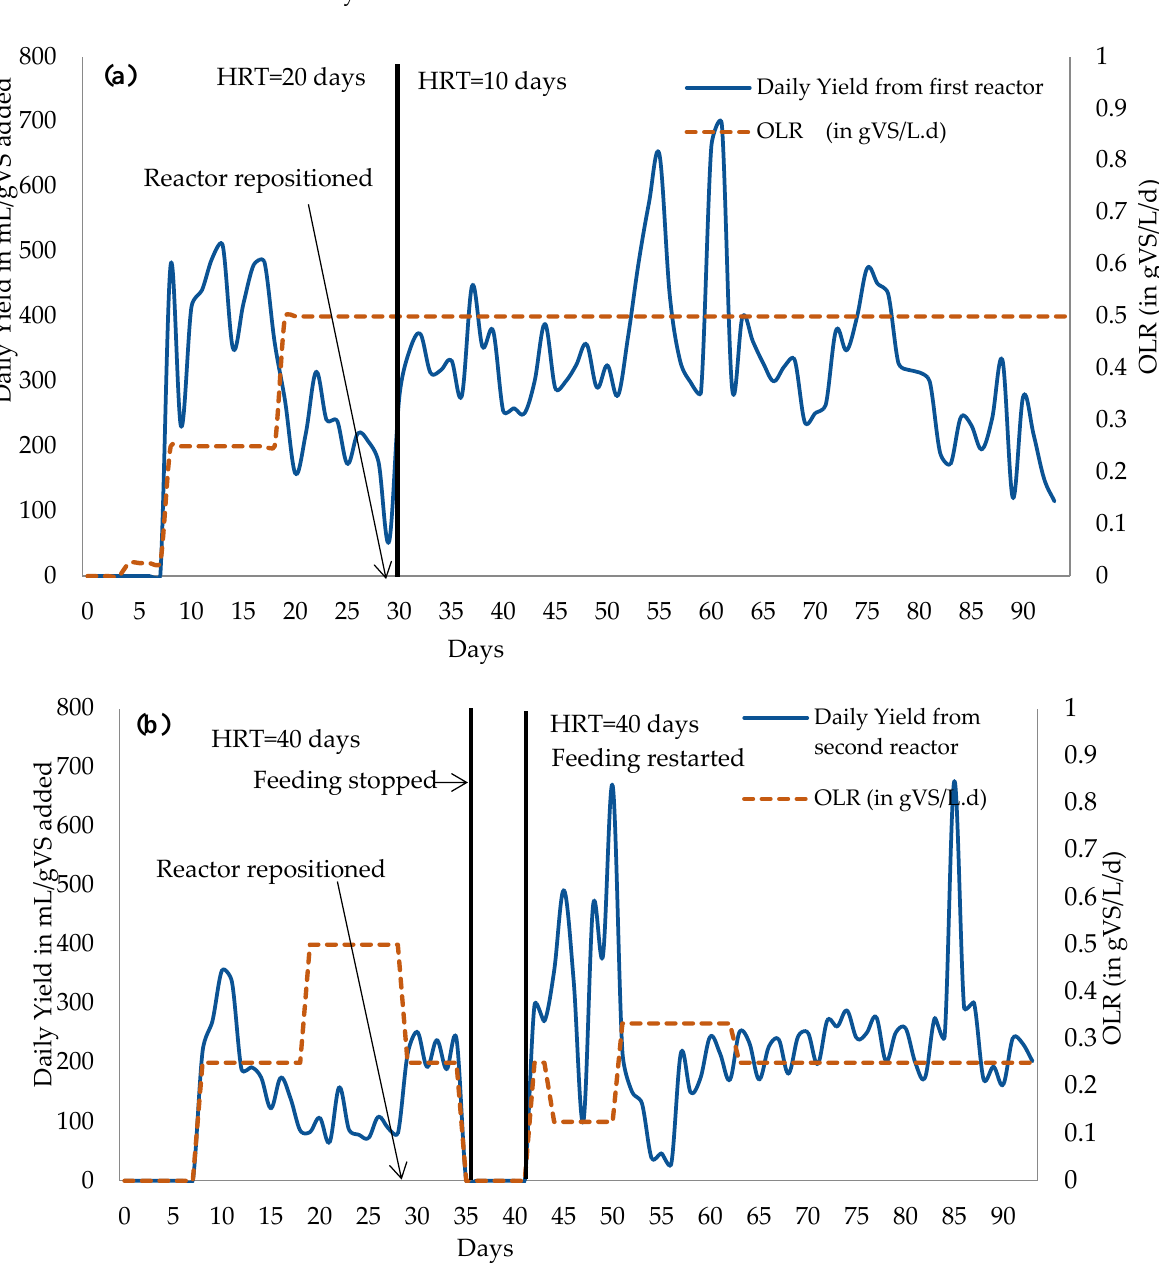
Figure 2. Daily biogas yield representing ( a ) first- and ( b ) second-stage reactor along with the changes in OLR, HRT, and major operational variations. Table 2. Summary of the major parametric changes, the reason behind making the change, and the response of the TSAD system towards the change.